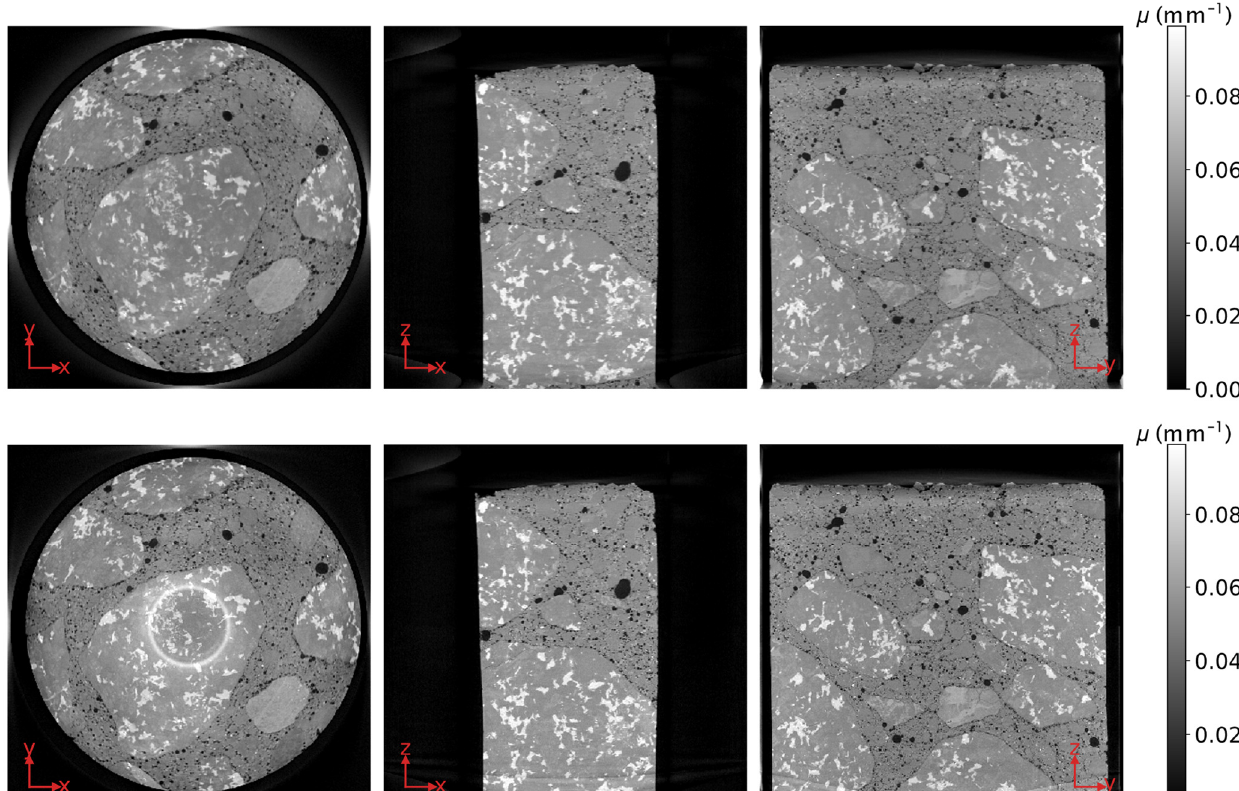
Figure 8. Orthogonal slices through the volume of a concrete rod as reconstructed by simultaneous iterative reconstruction technique (SIRT, top row) and conjugate gradient (CG, bottom row). The volume has the same size as the volume shown in Figure 1 through omission of its upper and lower slices. The position of the slices shown corresponds precisely to that of the slices in Figure 1. Table 1. Comparison of the performance of the reconstruction algorithms.